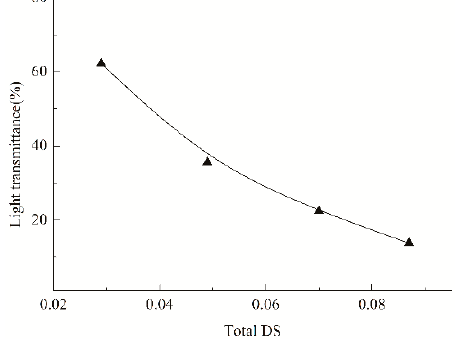
Figure 6. Light transmittances of cooked HCS pastes.